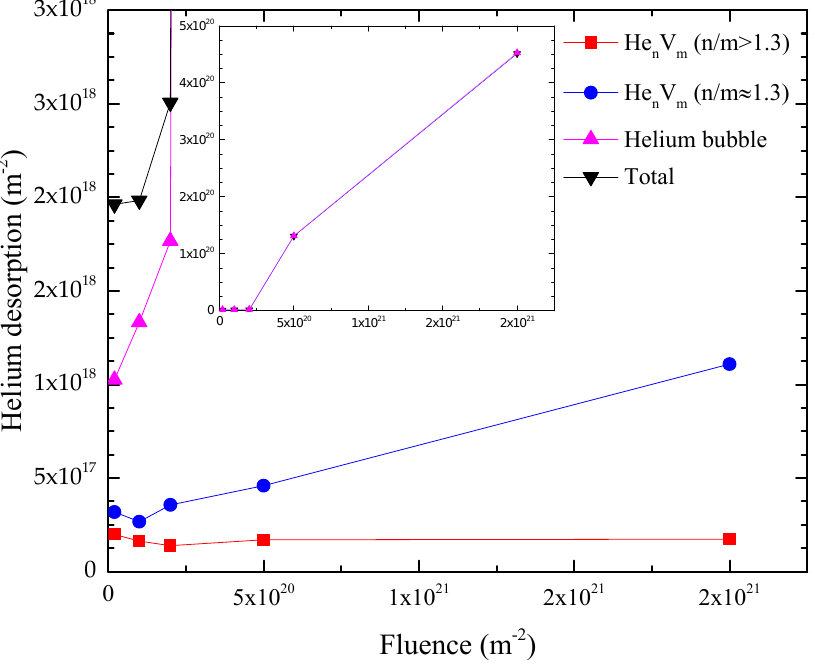
Figure 5. Amounts of helium released from various defect clusters and total helium amount released in specimens irradiated at 523 K to various fluences.